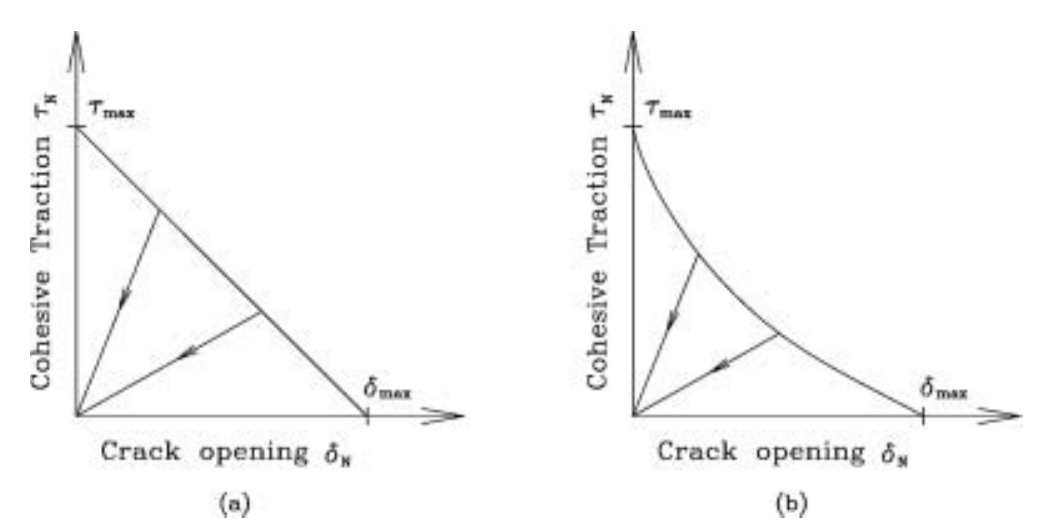
Fig. 5. Cohesive models, in which the area under a cohesive law is the fracture energy G F ; (a) a linear and (b) a general nonlinear cohesive